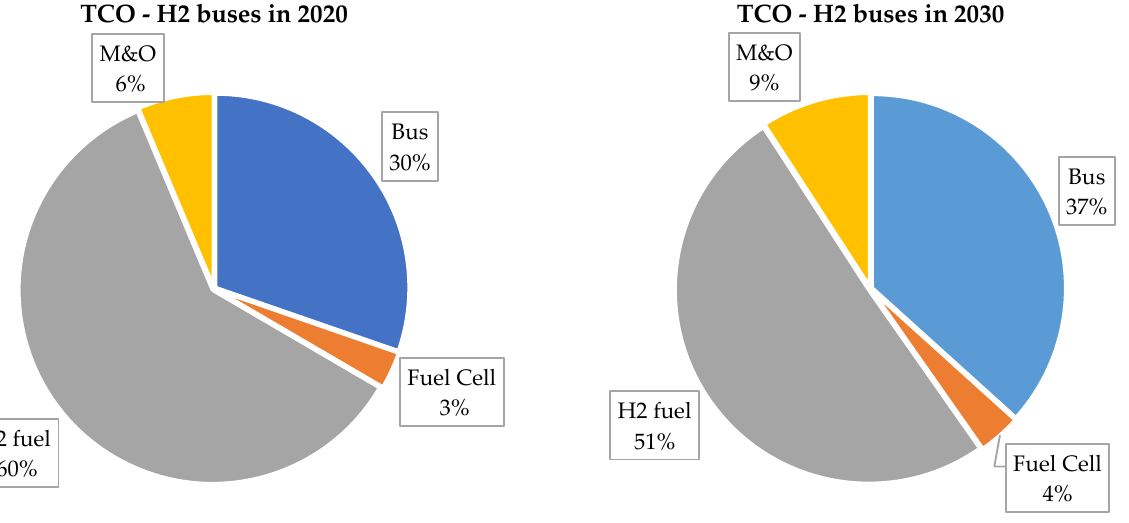
Figure 13. Hydrogen fuel cell bus TCO evolution costs for line S1/S2.